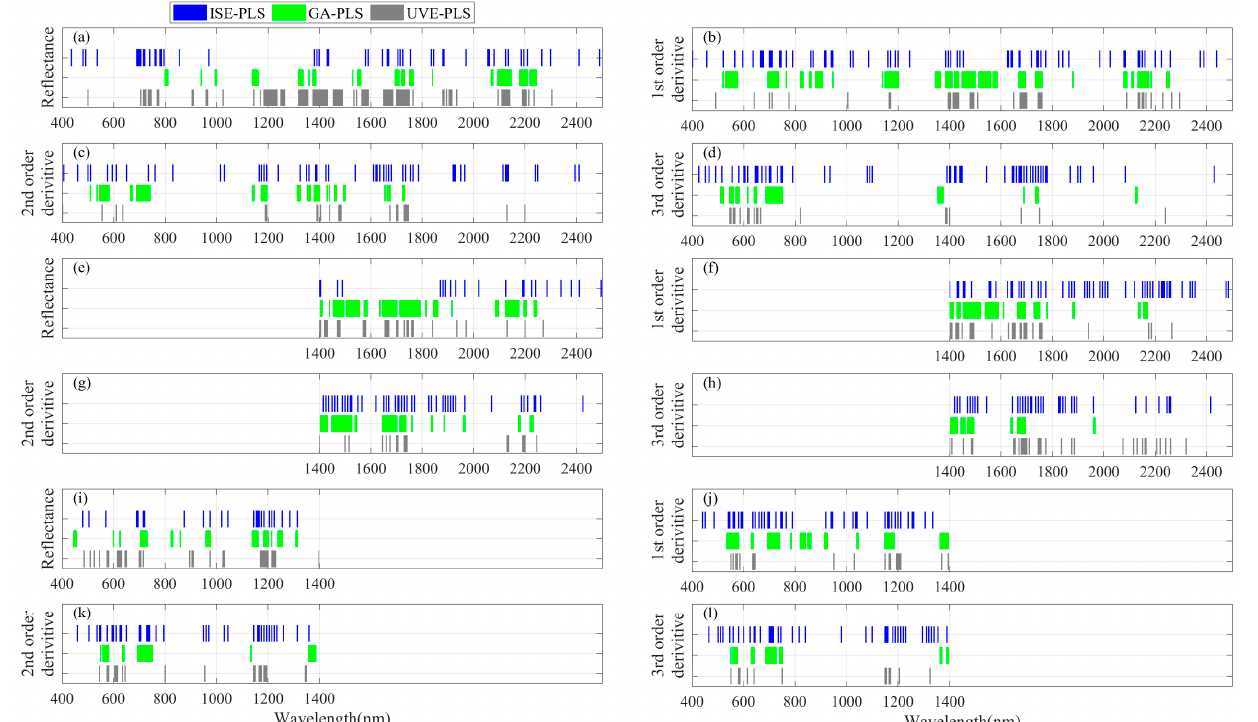
Figure 6. Distribution of bands selected by different band-selection methods for LNC estimation from field-measured spectra at three different spectral domains: ( a – d ), 400–2500 nm; ( e – h ), 1400–2500 nm; ( i – l ), 400–1400 nm. The locations of the color blocks in the Wavelength-axis represent the bands involved in different PLS (blue for ISE-PLS, green for GA-PLS and grey for UVE-PLS) regression models.